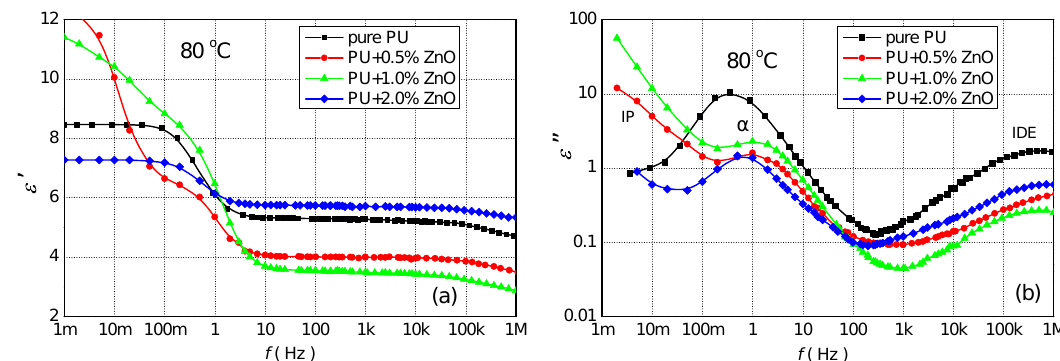
Figure 6. The frequency dependence of ( a ) the real and ( b ) imaginary parts of the complex permittivity for polyurethane resin and their various nanocomposites at temperature 80 °C.